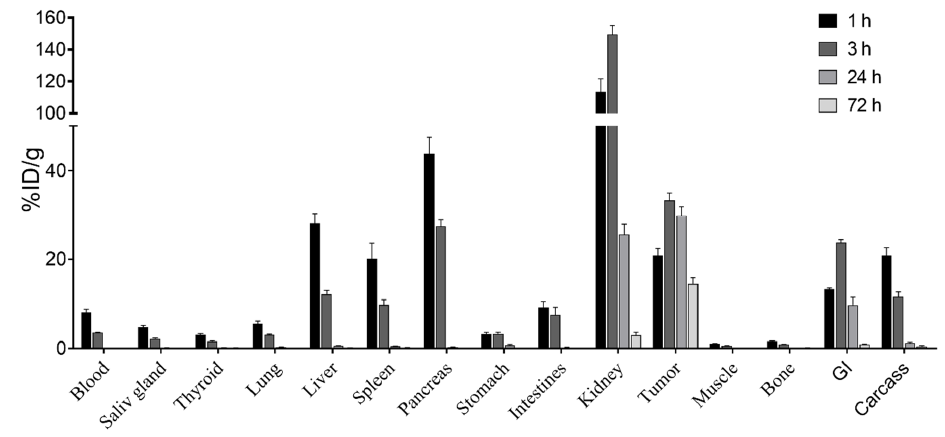
/ c nu / nu mice with PC-3pip (GRPR and PSMA positive) Figure 6. Biodistribution of [ 125 I]I-BO530. Balb/c nu/nu mice with PC-3pip (GRPR and PSMA Figure 6. Biodistribution of [ 125 I]I-BO530. Balb xenografts were injected with 40 pmol (30 KBq) of labeled heterodimer. Data are presented as mean value ± standard deviation.